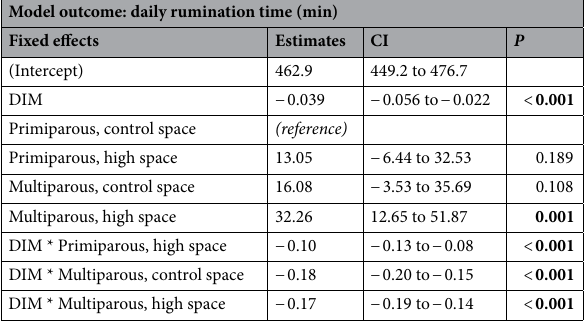
Table 3. Results from the mixed effects model (Eq. 4) to predict daily rumination time (minutes) from parity- trial group and days in milk (DIM) using data from a long-term randomised controlled trial to evaluate the impact of living space on housed dairy cows. Significant values are in [bold].